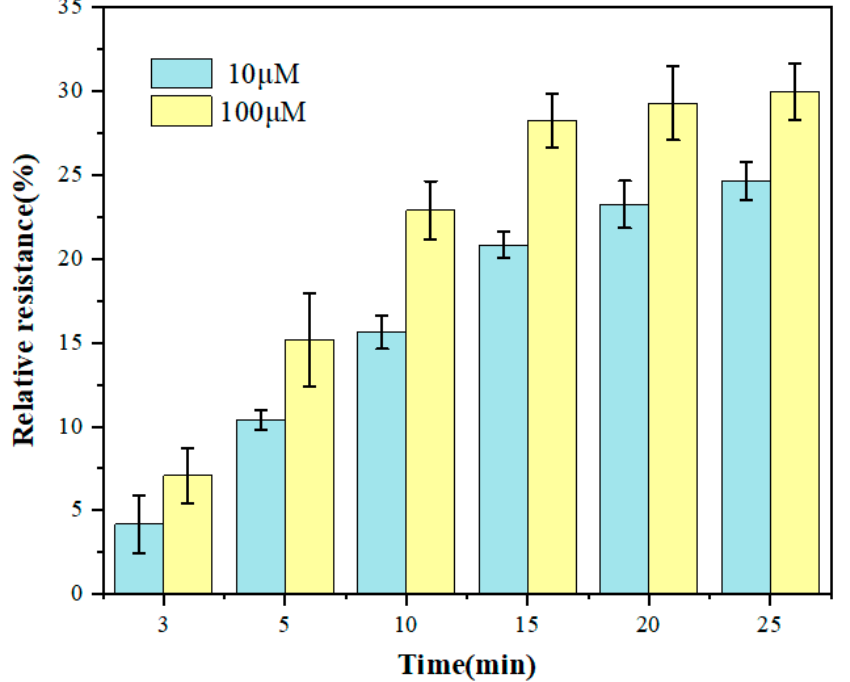
Figure 6. The relative resistance of the GCE/NGR/AuNPs/Sub ‐ DNAzyme duplex after incubation in different Ca 2+ concentrations at different times (The error bars were determined in three duplicates).